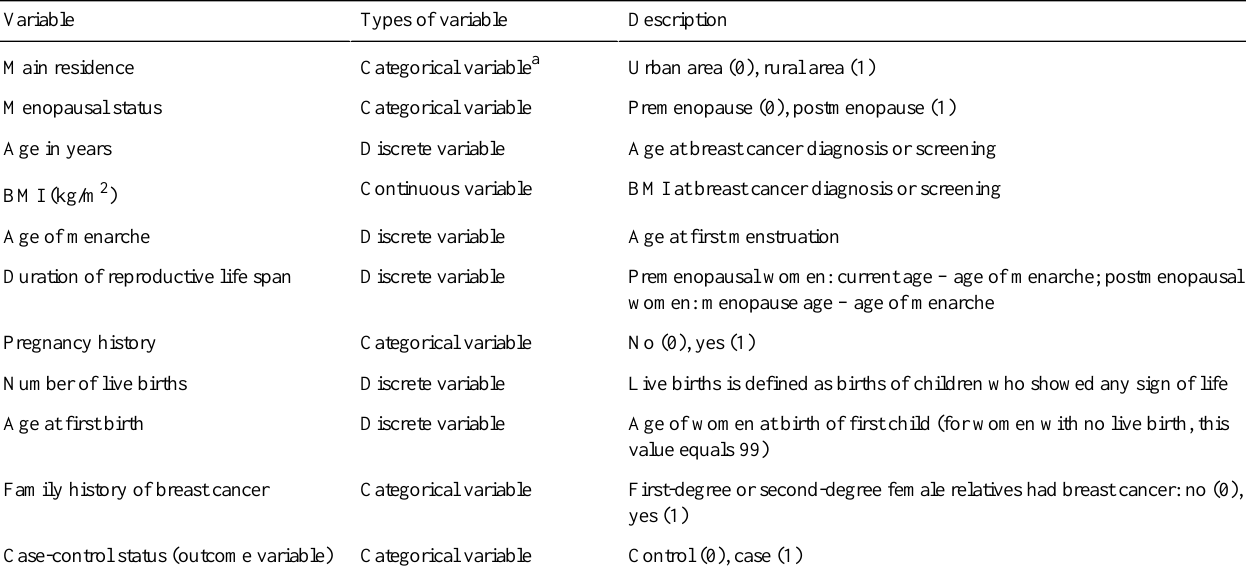
Table 1. Descriptions and details of the variables included in the machine learning algorithms. DescriptionTypes of